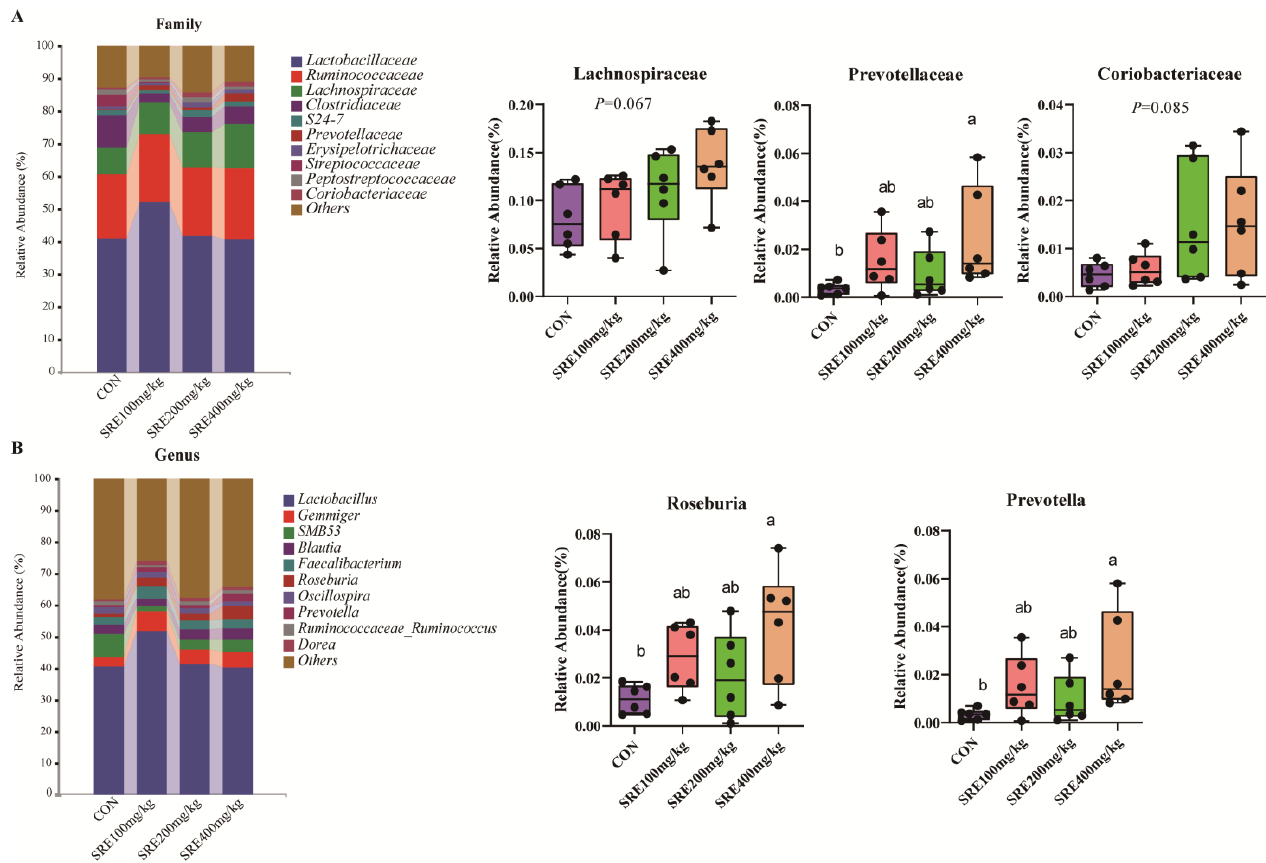
Figure 3. Effects of supplementation with stevia residue extract in the diet on the colonic microbial composition of weaned piglets on day 42 of the trial. The stacked bar chart on the left shows the top 10 species in relative abundance at the family level, and the box plot on the right shows the differential species among the top 10 species at the family level ( A ); the stacked bar chart on the left shows the top 10 species in relative abundance at the genus level. The box plot on the right shows the differential species among the top 10 species at the genus level ( B ). Con: control group without the supplementation of stevia residue extract in the diet; SRE100 mg/kg: diets supplemented with 100 mg/kg stevia residue extract group; SRE200 mg/kg: diets supplemented with 200 mg/kg stevia residue extract group; SRE400 mg/kg: diets supplemented with 400 mg/kg stevia residue extract group. The relative abundance of microbes was compared by Kruskal – Wallis test followed by the Dunn test, and false discovery rate (FDR) values were estimated using the Bonferroni method to control for multiple testing (n = 6). Labeled means in a row with different letters differ, p < 0.05.